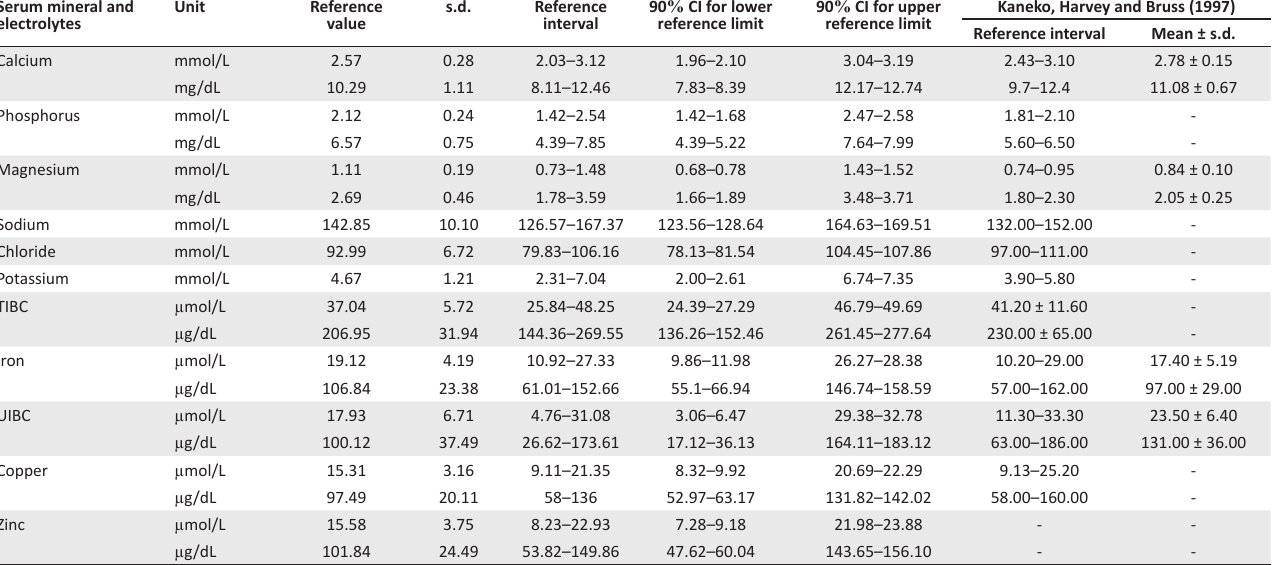
TABLE 3: Reference intervals for serum minerals and electrolytes in buffalo heifers. Serum mineral and Unit electrolytes